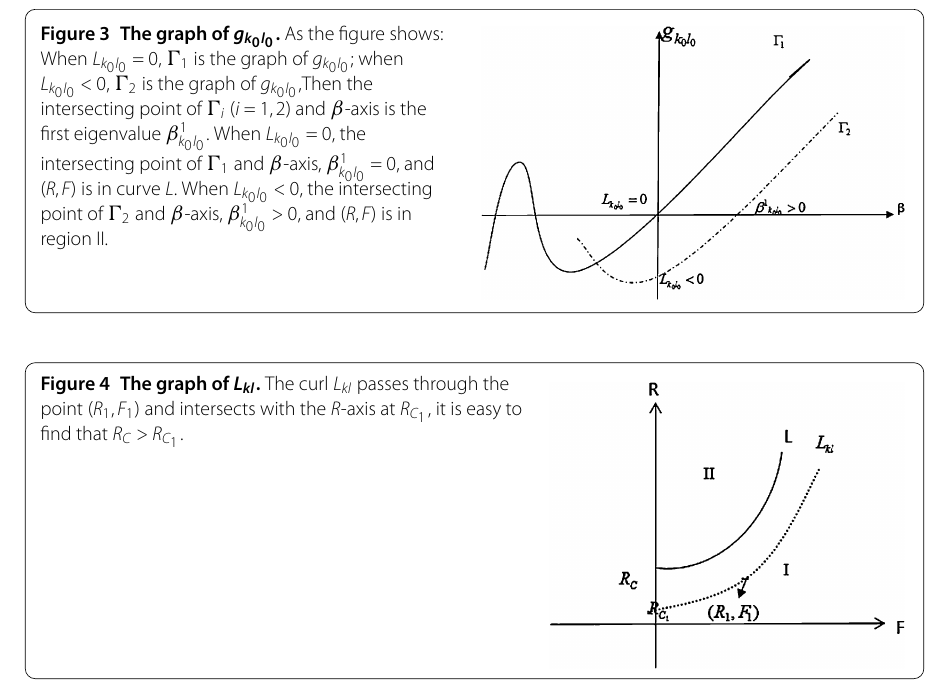
, it is easy to 1